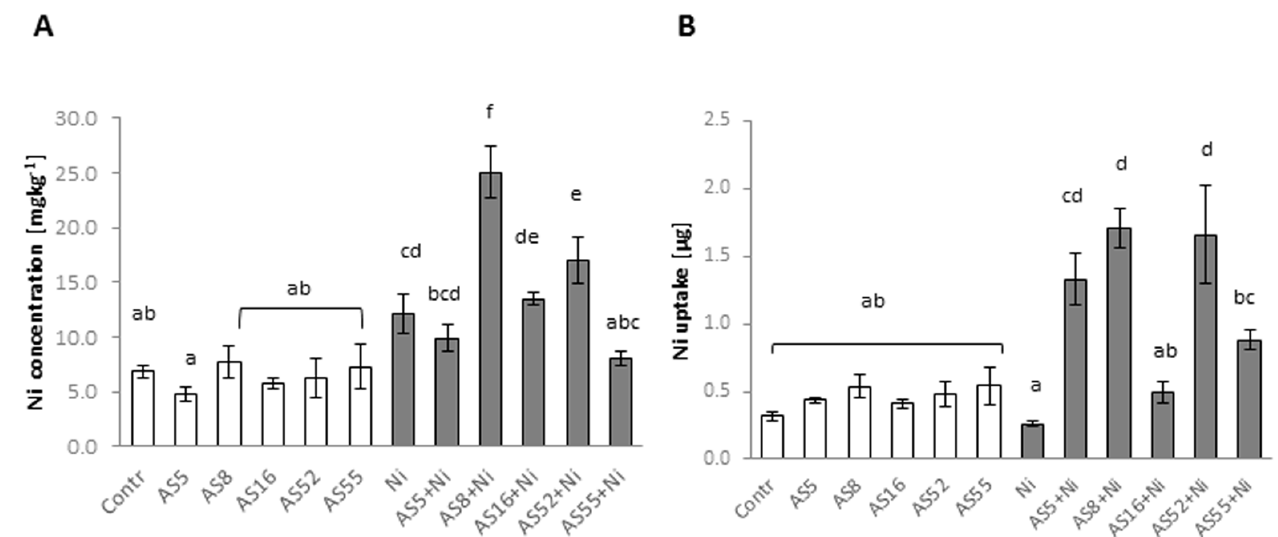
Figure 5. Nickel concentration ( A ) and uptake ( B ) in aboveground parts of Arabidopsis non-exposed (bars in white) and exposed to 200 µM Ni (bars in grey) in the absence or presence of rhizobia strains. Error bars represent ± SD. The same letters indicate the homogenous groups according to the Tukey HSD test at the level p = 0.05.